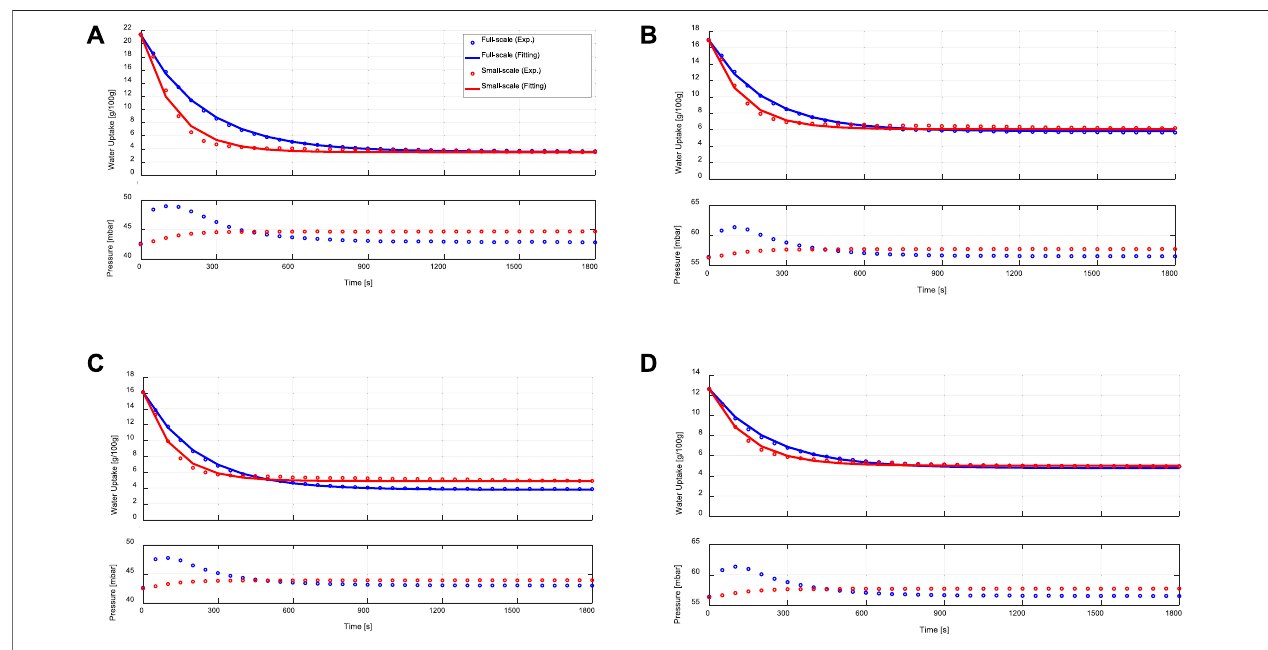
FIGURE 6 | Desorption kinetic (upper) and vapour pressure (lower) curves of the APHE (full-scale measurements) and its representative adsorbent sample (small- scale measurements) at evaporator, condenser/adsorption-end and desorption temperatures of (A) 15/30/90 ° C, (B) 15/35/90 ° C, (C) 10/30/90 ° C, (D) 10/35/90 ° C.